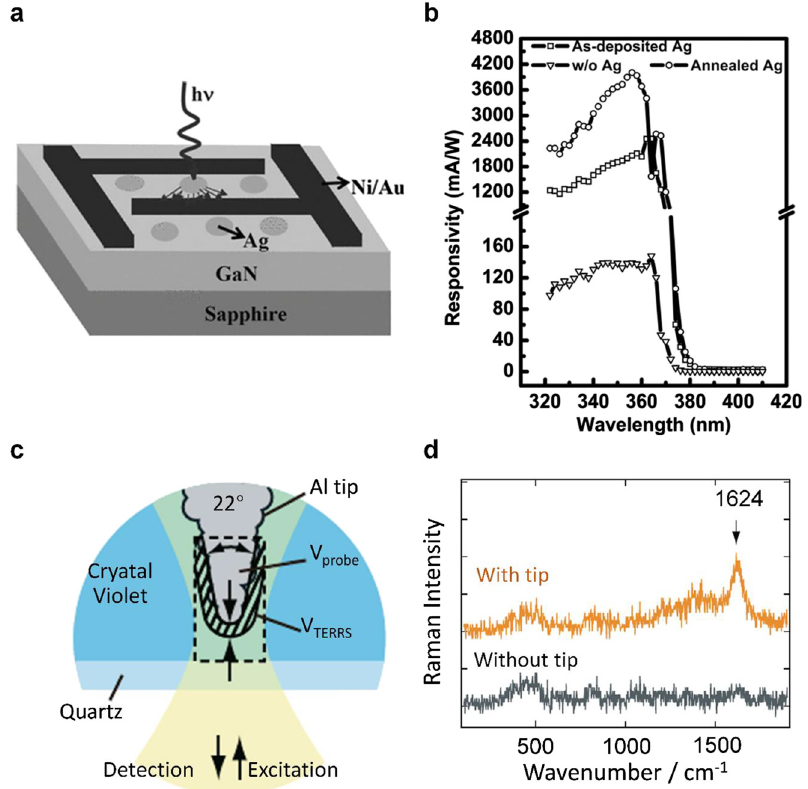
Figure 7: (a and b) A GaN-based UV photo- detector with plasmonic enhancement